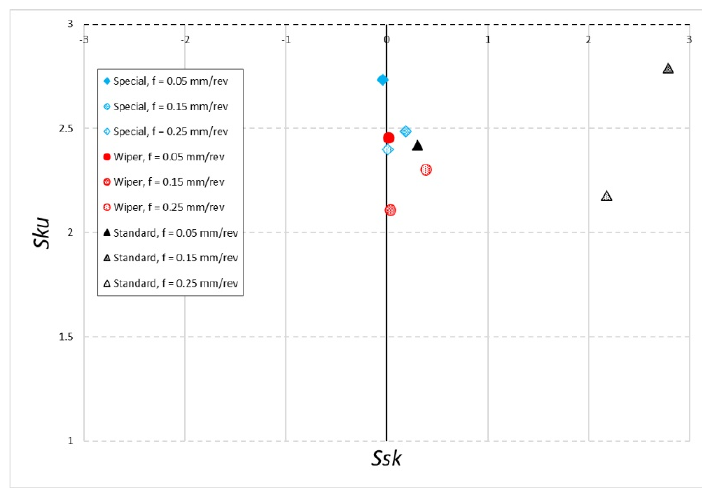
Figure 9. The Sku–Ssk map after wet machining